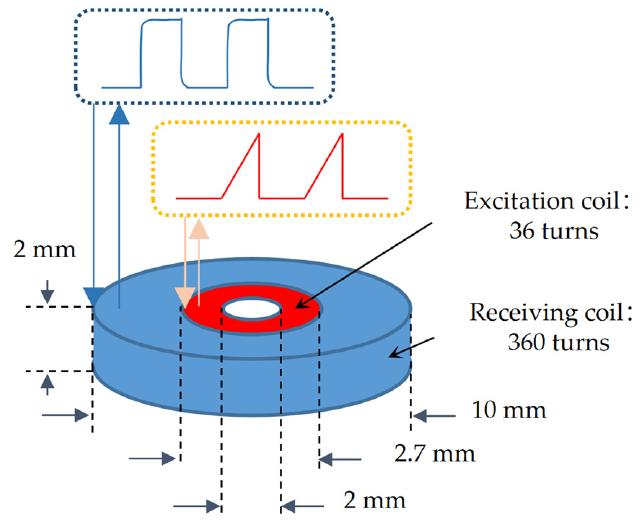
Figure 1. The structure of CPA-PEC sensor.